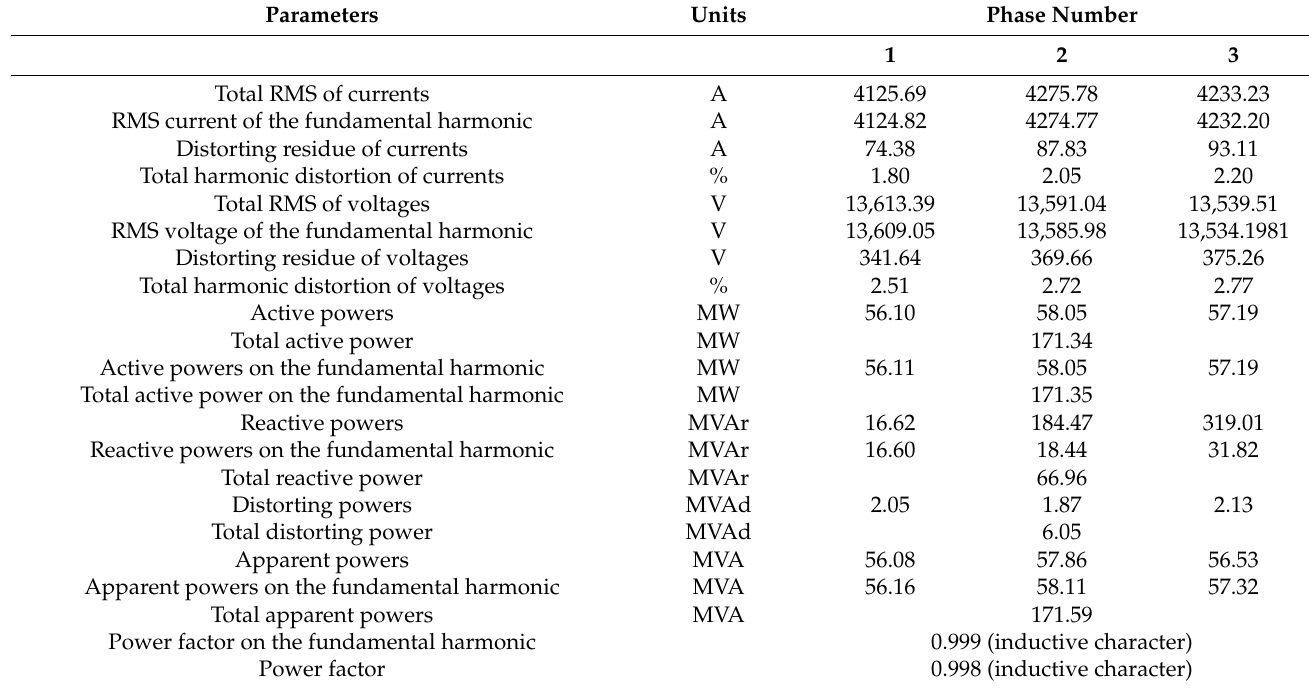
Figure 25. The harmonic spectra of three-phase active powers ( top ) and reactive powers ( bottom )—quantities acquired at the terminals of the main generator, corresponding to an active power of 171 MW. Table 7 gathers the results yielded by FFT and the first theory for the third case study. Table 7. Power quality indices, powers and power factor using FFT and the first theory—third case study.